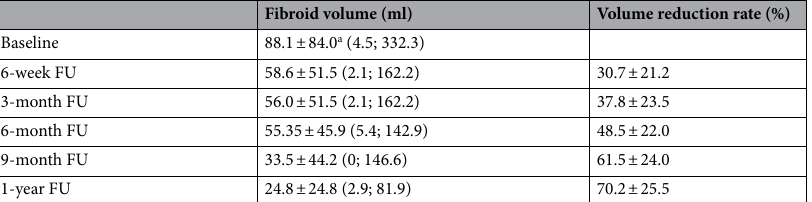
Table 4. Lesion volumes of HIFU-treated uterine fibroids at baseline and follow-up (6 weeks, 3, 6 and 9 months, 1 year after HIFU); corresponding volume reduction in % compared to initial lesion volumes. a Mean ± standard deviation (range).